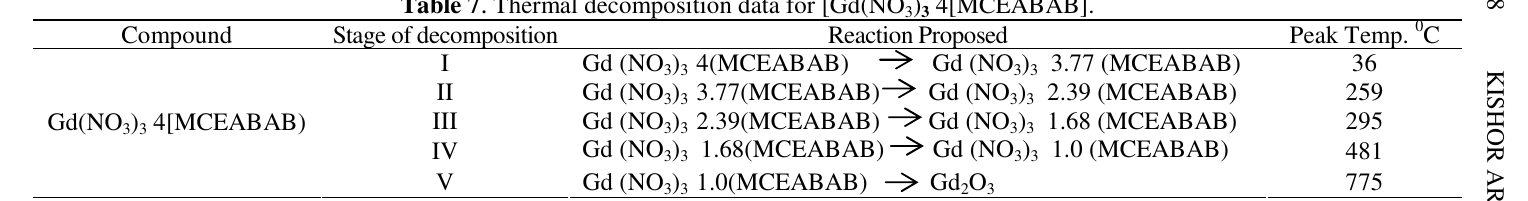
Table 8. Antifungal activities of some of the representative complexes of lanthanide(III) metal ions with Schiff base ligands (After 48 hours of incubation).